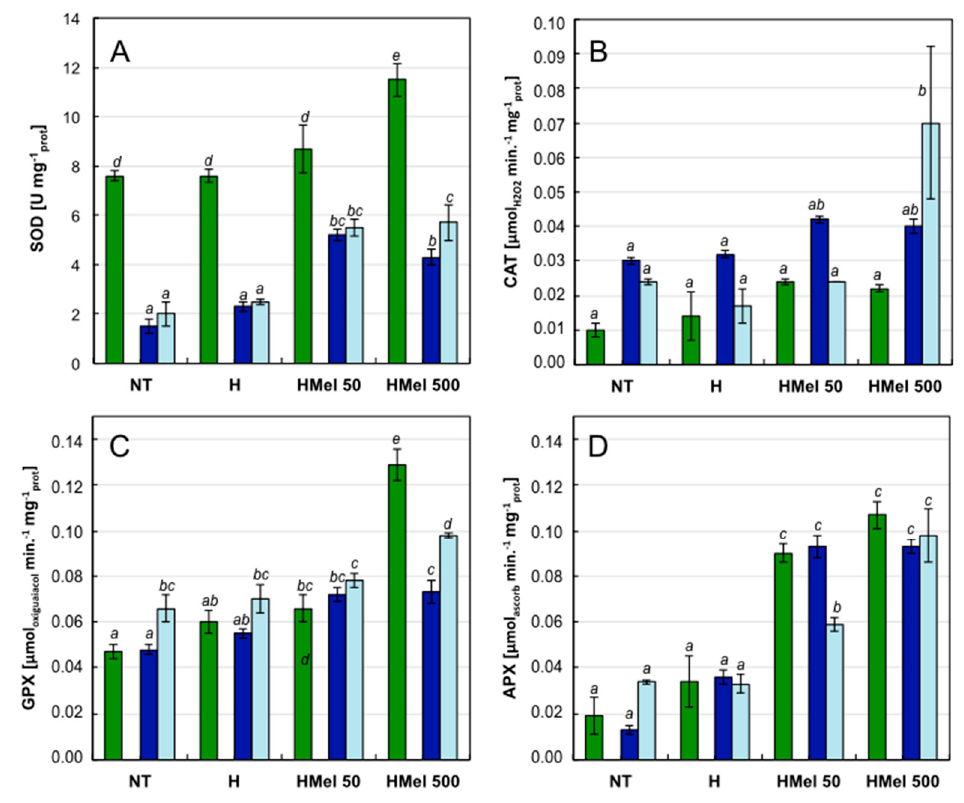
Figure 6. Effect of different maize seed hydropriming treatments on the antioxidant enzymes activities: SOD ( A ), CAT ( B ), GPX ( C ) and APX ( D ) in the axes isolated from non-treated seeds (NT), and those from hydroprimed with water (H) and with melatonin water solutions in concentrations: 50 μ M (HMel 50) and 500 μ M (HMel 500). The seeds were im- bibed/germinated in water at 5 °C in darkness for 14 days (S [ ■ ]—chilling stress), and subsequently regenerated at 25 °C for 1 day (R [ ■ ]—regeneration). Enzyme activities were also estimated in axes isolated from the seeds germinated for 24 h under optimal conditions 25 °C (C [ ■ ]—optimum, control conditions). The results are expressed as means of 6 – 9 meas- urements ±SEM. Two-way ANOVA and Duncan’s post-hoc tests were performed. The lowercase letters next to the values show statistical significance at the specified p . SOD—ANOVA results: Seed Variant (NT,H,HMel 50,HMel 500) F (3;79) = 39.69, p < 0.000001; Conditions (C,S,R) F (2;79) = 167.53, p < 0.000001; interaction Seed Variant × Conditions F (6;79) = 2.96 p < 0.01.